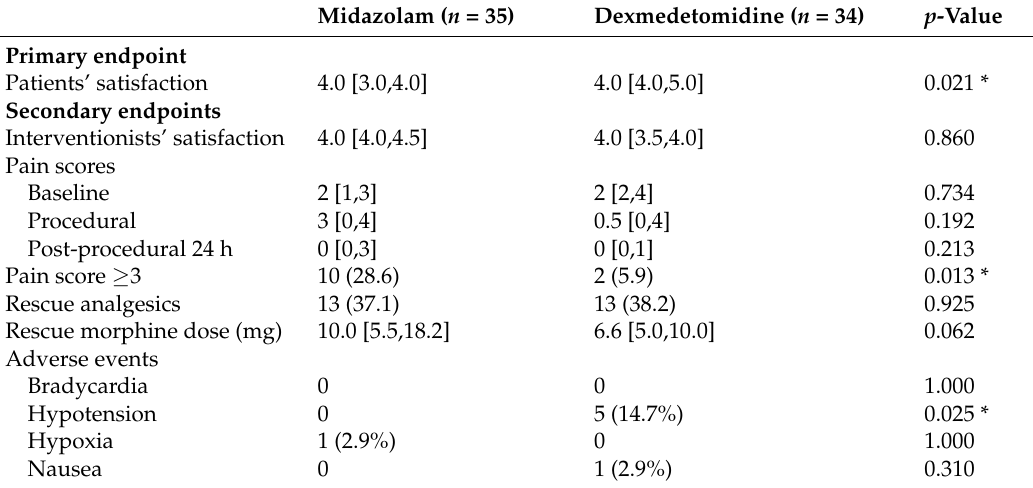
Table 2. Primary and secondary endpoints.